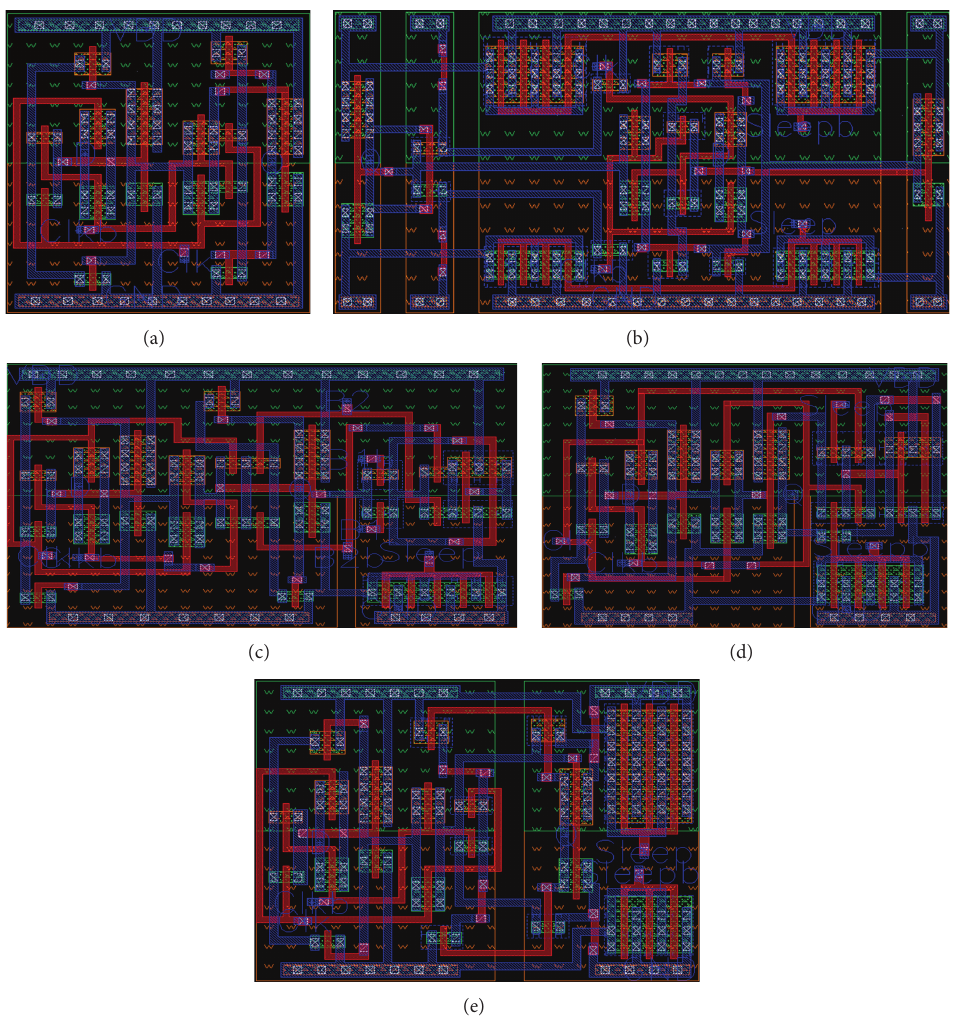
Figure 10: The layouts of different flip-flops: (a) ST-TG-FF, (b) Mutoh-FF, (c) Balloon-FF, (d) Memory-TG-FF, and (e)